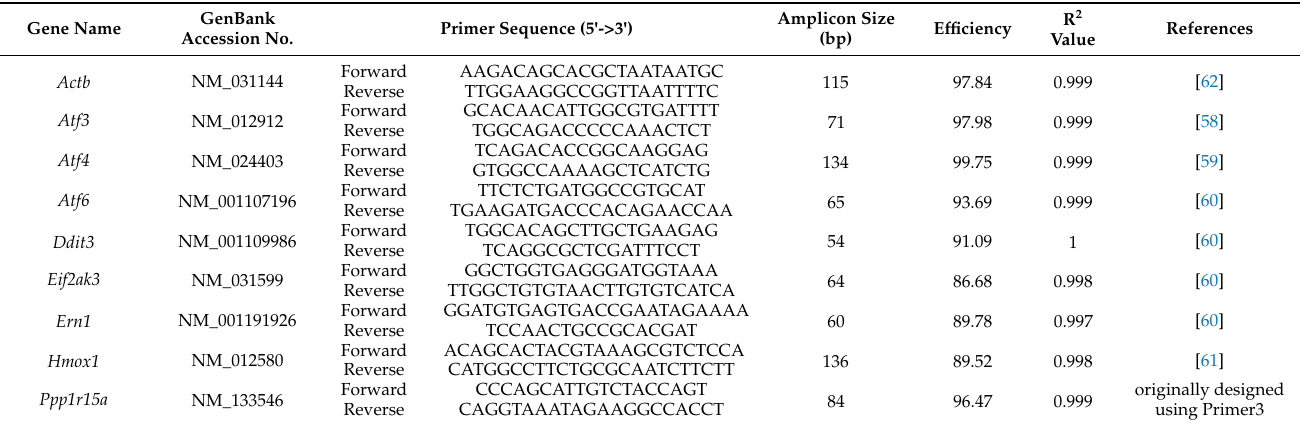
Table 1. RT-qPCR